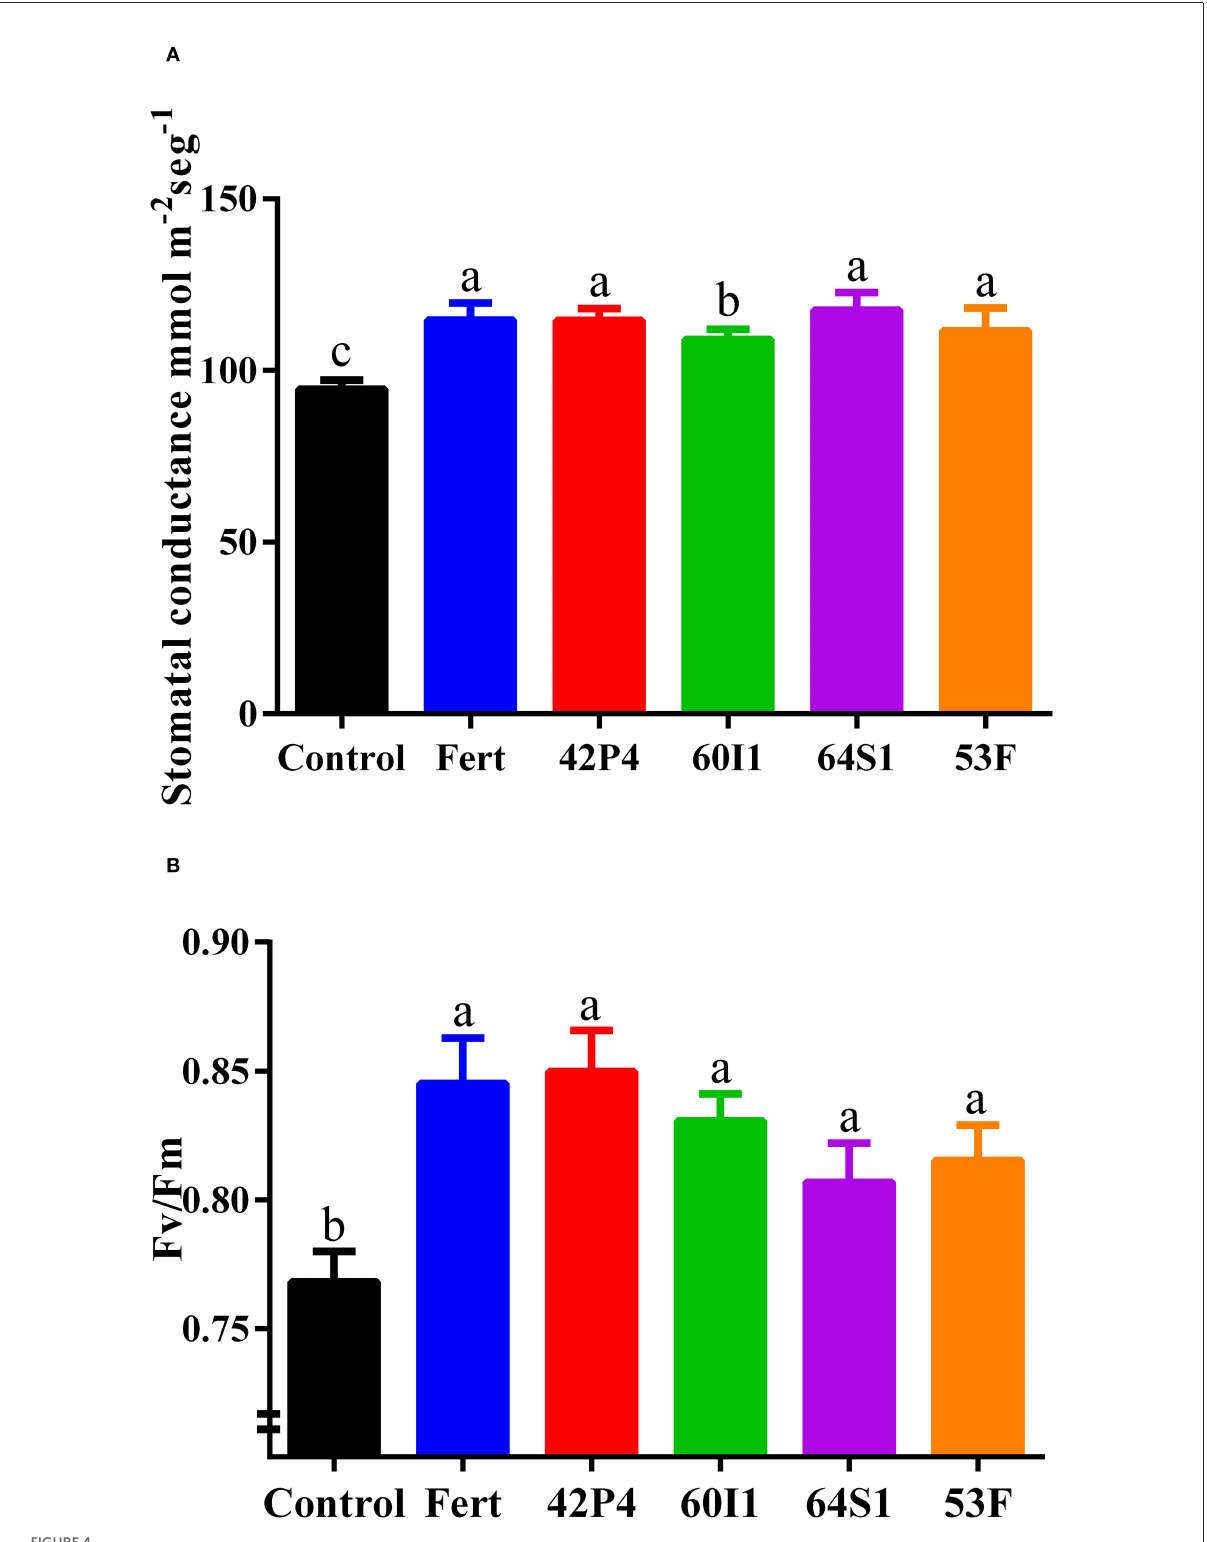
FIGURE4 (A) Stomatal conductance and (B) Chlorophyll quantum efficiency (Fv/Fm) of pepper plants of 90 day-old grown in pots and treated with: Fert: Fertilized; 42P4: Pseudomonas 42P4; 60I1: Cellulosimicrobium 60I1; 64S1: Enterobacter 64S1; 53F: Ochrobactrum 53F and Control (without bacteria). Data are presented as mean ± SEM of 10 independent biological replicates. Different letters indicate significant differences according to one-way ANOVA with Duncan’s multiple range test. P (A) = 0.0025 and P (B) =